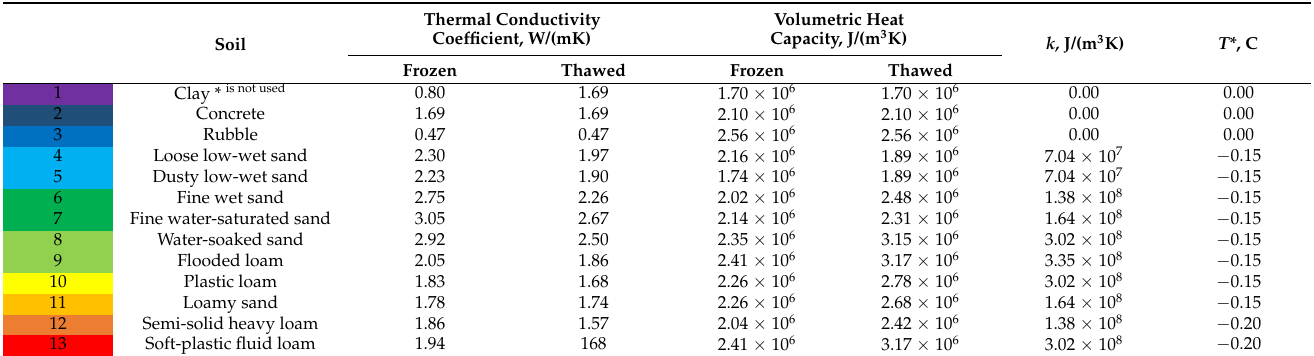
Table 1. Thermophysical characteristics of the soils under Building I.